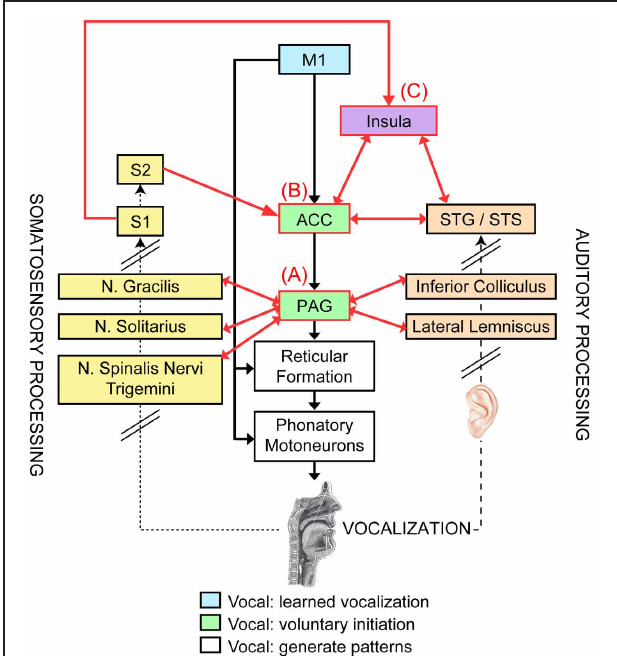
FIGURE 1 | Neural networks of vocal motor control (central column), somatosensory (left) and auditory feedback processing (right), and hypothesized regions of sensory-motor control of voice [modified from a model proposed by Jürgens (2009)]. The vocal motor control hierarchy starts with the generation of complete vocal patterns from the reticular formation and phonatory motoneurons (white boxes), and then the next highest level of control (green boxes) stems from the anterior cingulate cortex (ACC) and periaqueductal gray (PAG), which can initiate and emotionally motivate vocal responses. The highest level of vocal control comes from the primary motor cortex (M1, blue box; its modulatory brain regions are not depicted), which is responsible for producing learned vocalizations (i.e., speech and song). Somatosensory feedback (dotted arrow) from various receptors distributed throughout the vocal tract is processed in the ascending somatosensory pathway (yellow boxes, left; black slanted lines indicate that only selected regions of this pathway are shown) and transmitted to the primary and secondary somatosensory cortex (S1, S2). Auditory feedback (dashed arrow) from the vocalization is processed by the ascending auditory pathway and auditory cortical regions (orange boxes, right). Potential neural regions that integrate sensory feedback processing with vocal motor control are indicated with red-outlined boxes, and their shared connections are represented by red arrows: (A) the PAG, (B) ACC, and (C) the insula (in purple, classified as a higher-order associative